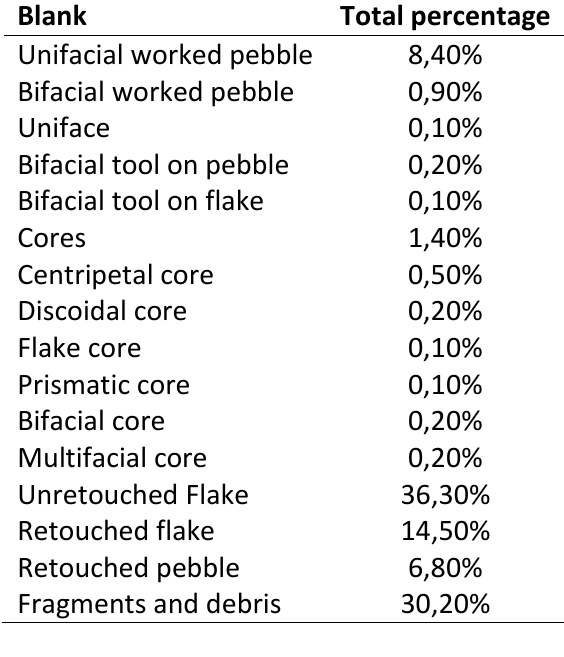
Table 2. Main techno-typological lithic categories.